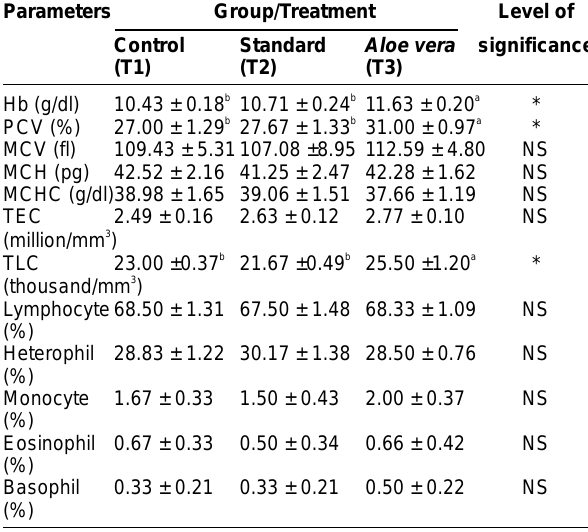
Table-2. Effects of supplementation of Aloe vera on Haematological parameters of broiler chicks